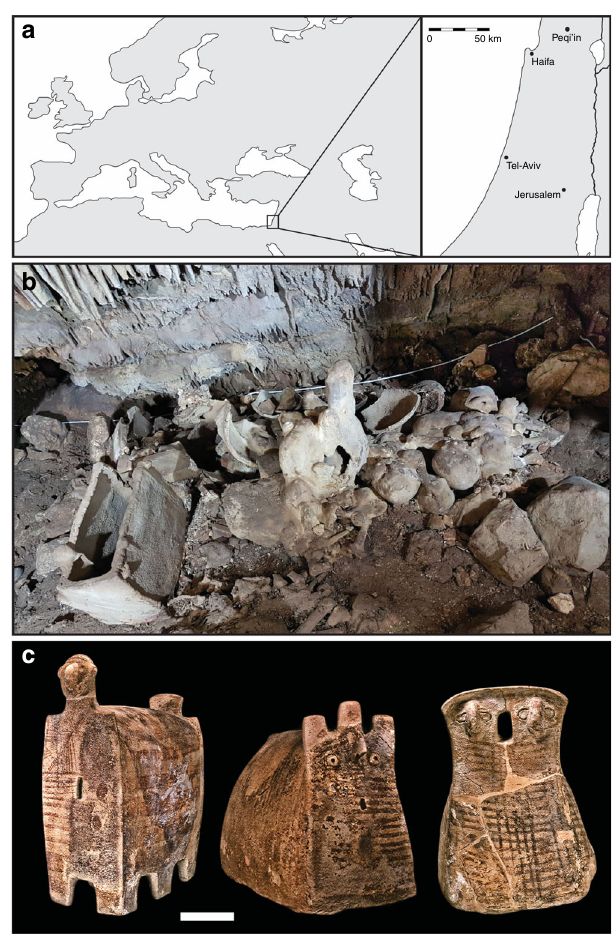
Fig. 1 Site background. a Location of the site of Peqi ’ in Cave. b Photo of the interior of Peqi ’ in Cave. Photo Hila May, courtesy of the Dan David Center of Human Evolution and Biohistory. c Photo of several burial urns (ossuaries) from Peqi ’ in Cave. Scale bar: 10 cm. Photo Mariana